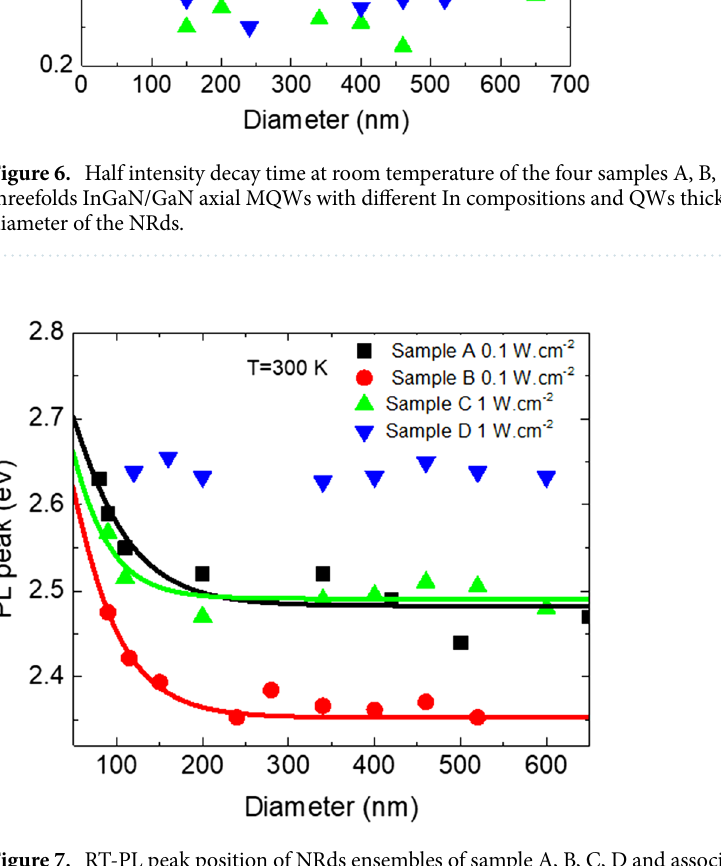
Figure 7. RT-PL peak position of NRds ensembles of sample A, B, C, D and associated fit (in solid line) with 1-D relaxation model represented by Eq. (1). Fit of sample D is absent because no significant strain relaxation has been